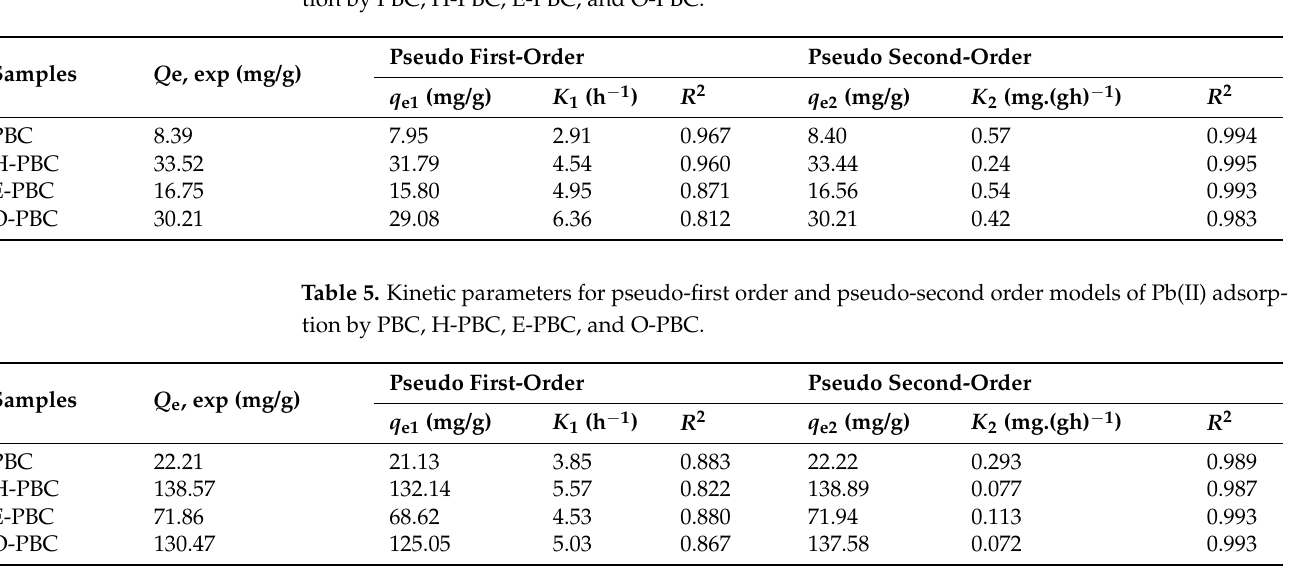
Figure 3. Adsorption kinetic equations fitted for ( A ) Ni(II) and ( B ) Pb(II) with PBC, H-PBC, E-PBC, and O-PBC. Experimental conditions: adsorbent dosage = 10 mg; [Ni(II)] and [Pb(II)] = 40 mg/L; pH = 5.0; temperature = 298.15 K. Table 4. Kinetic parameters for pseudo-first order and pseudo-second order models of Ni(II) adsorption by PBC, H-PBC, E-PBC, and O-PBC.